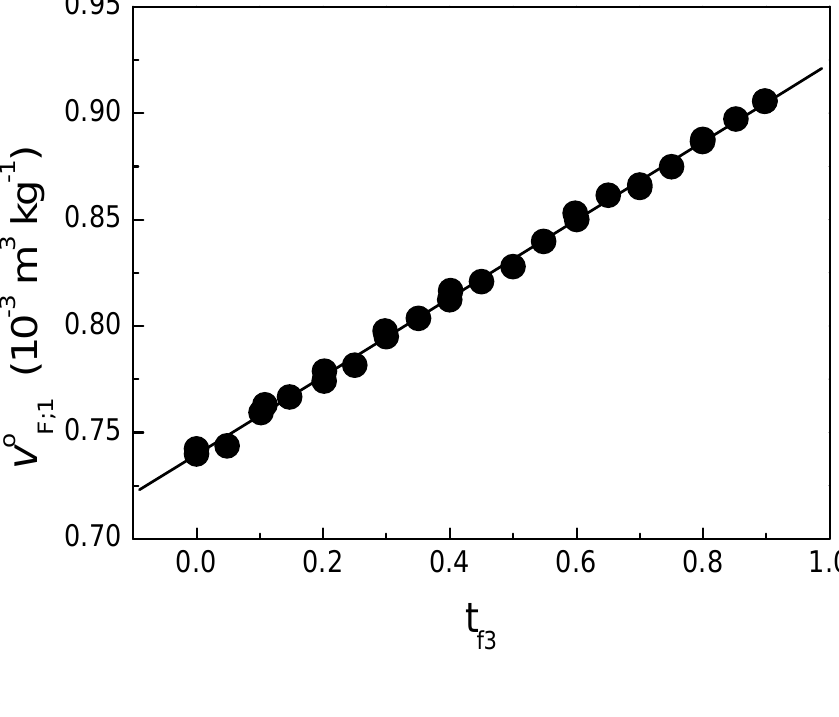
Figure 8. Specific partial volume at infinite dilution in water at 30 ° C, of the fraction F composed of Lysozyme (component 2) and decyltrimethylammnonium bromide (component 3) as function of the mass fraction of component 3 in fraction F. Because the is very close to linear, the interaction term Δ v o behavior of v o F;1 taken from ref.